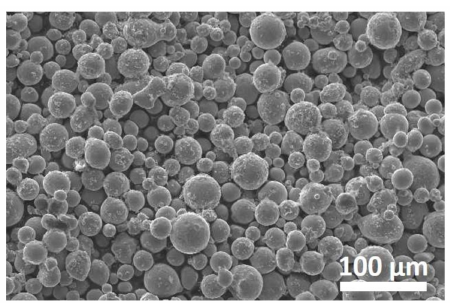
Figure 2. SEM image of powders used for the fabrication of